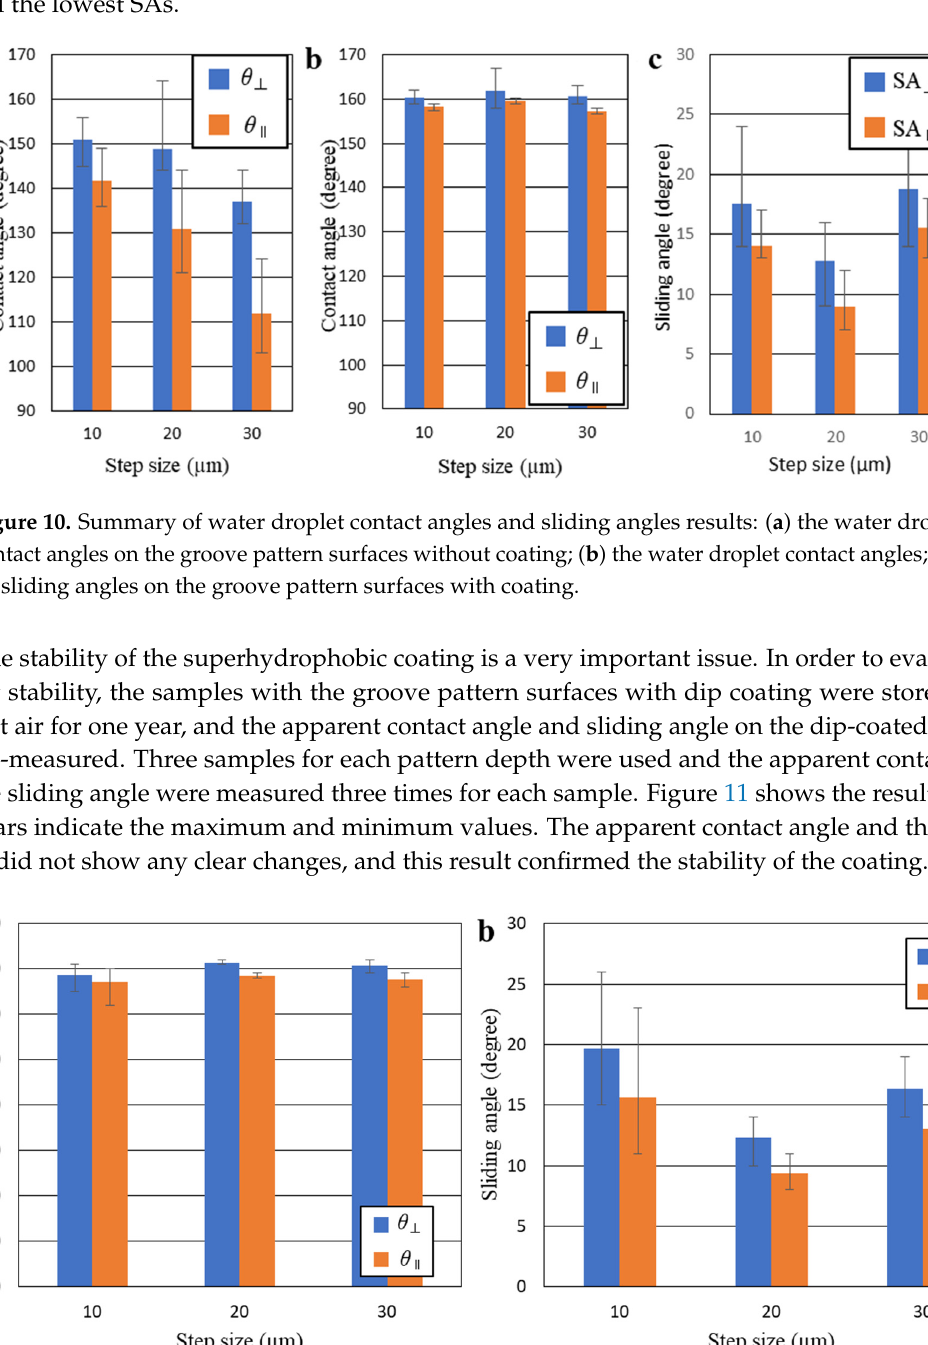
Figure 11. Apparent water droplet contact angles and sliding angles results after one year in ambient air: ( a ) the water droplet contact angles; and ( b ) sliding angles on the groove pattern surfaces with coating.